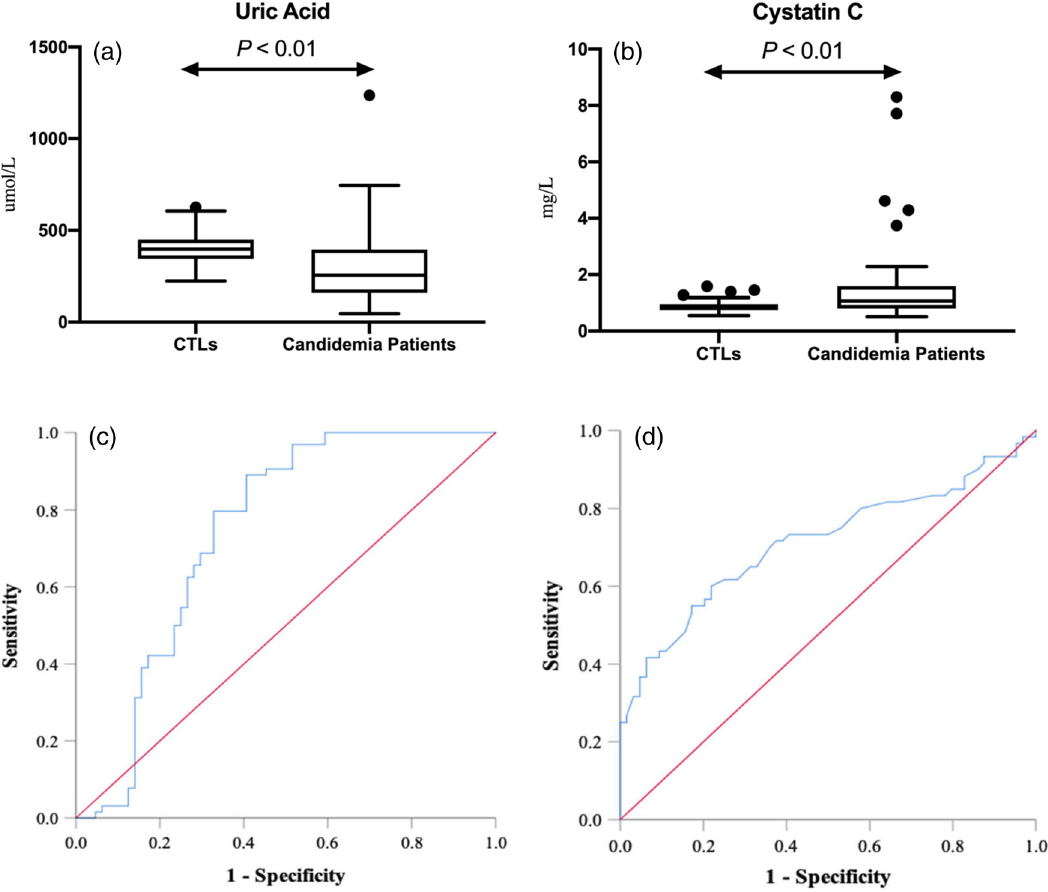
Figure 1: Box - whisker plot for UA ( a ) and cystatin C ( b ) , and receiver operating characteristic curve for UA ( c ) , and cystatin C ( d ) in patients with or without candidemia.